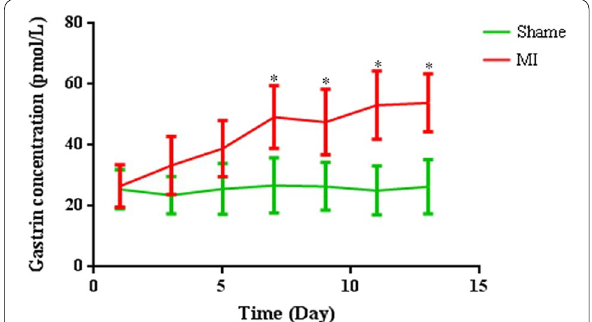
Fig. 1 Comparison of plasma concentrations of gastrin at different days (day 1, 3, 5, 7, 11, and 13) in the myocardial infarction (MI) mice and in sham-operated mice. Data are expressed as the mean n 8. * P < 0.05, vs. sham-operated =